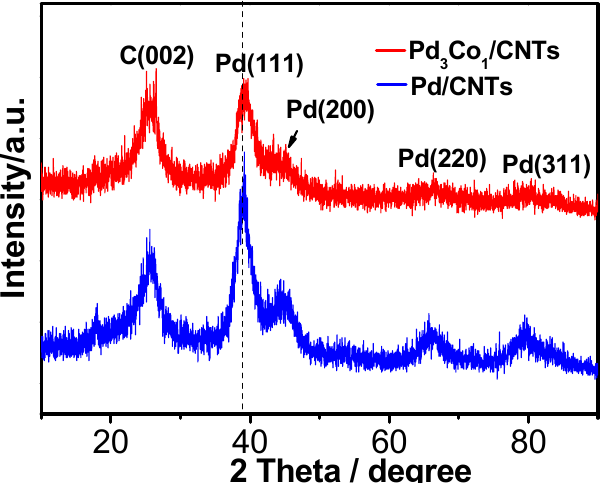
Figure 1. XRD patterns of the Pd/CNT and Pd 3 Co 1 /CNT catalysts.